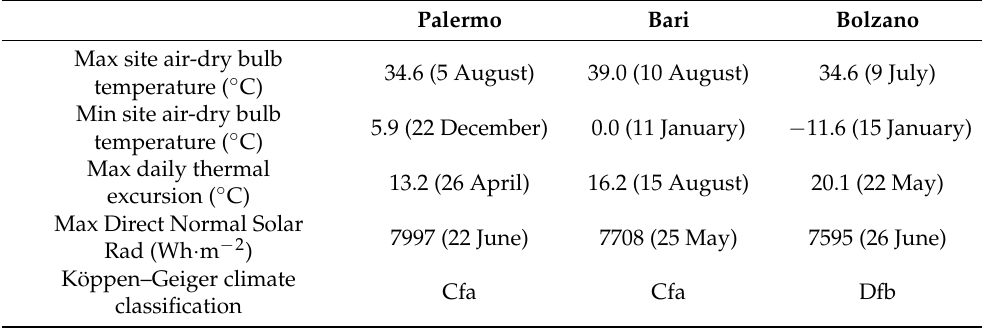
Table 5. Site climatic properties (EnergyPlus weather data [42]).